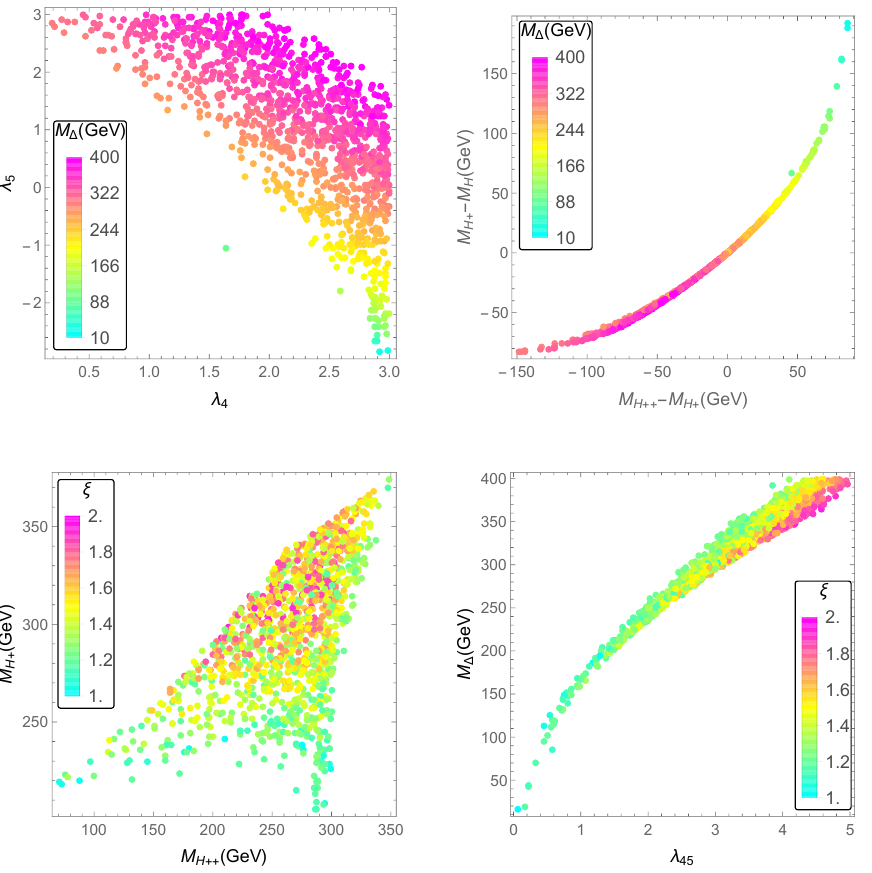
Figure 3 . SFOEWPT viable benchmark points for our setup 1. In the upper row, we show benchmark points with ξ > 1 , while in the second row, we show explicitly the value of ξ on different parameter planes. See the main text for